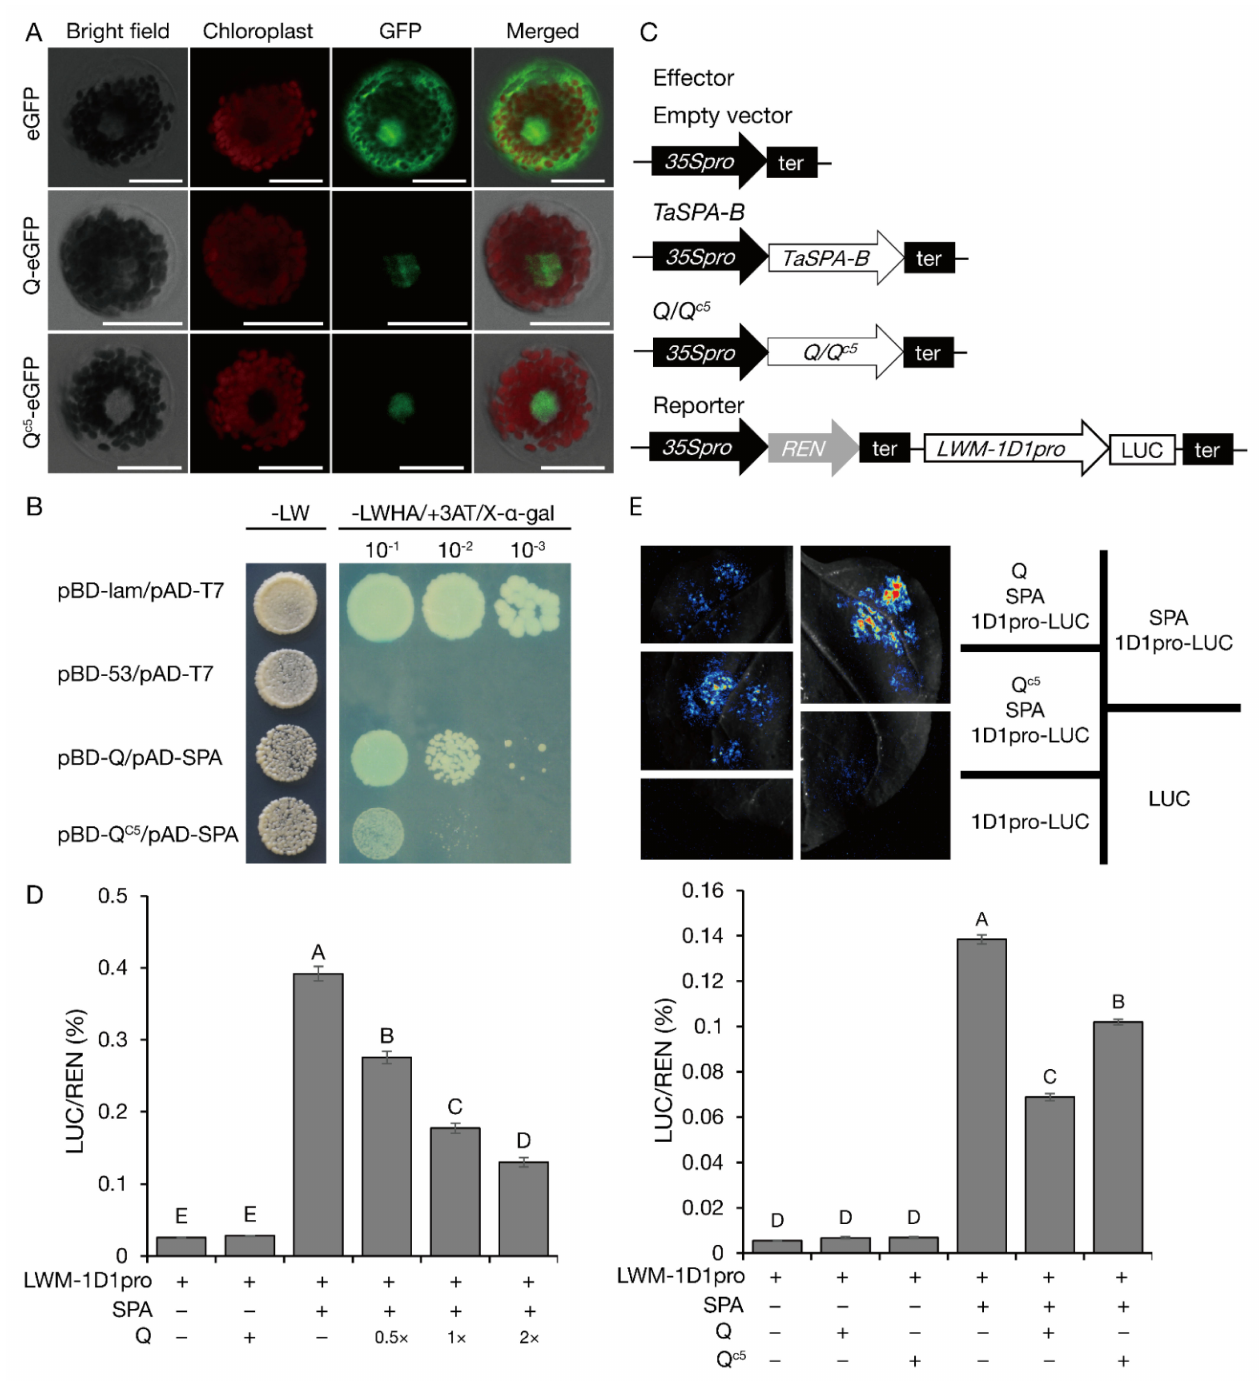
Figure 4. Q physically interacts with SPA to regulate the expression of SSP genes. ( A ) Q and Q c5 are localized to the nucleus of wheat mesophyll protoplasts. ( B ) Q c5 interacts with SPA more weakly than Q in yeast two-hybrid assays. Y2HGold yeast cells transformed with the labeled constructs were assayed for growth on SD medium lacking LW and for LacZ activities on SD-LWHA medium supplemented with X- α -gal. pAD, GAL4 activation domain; pBD, GAL4 DNA-binding domain; 4